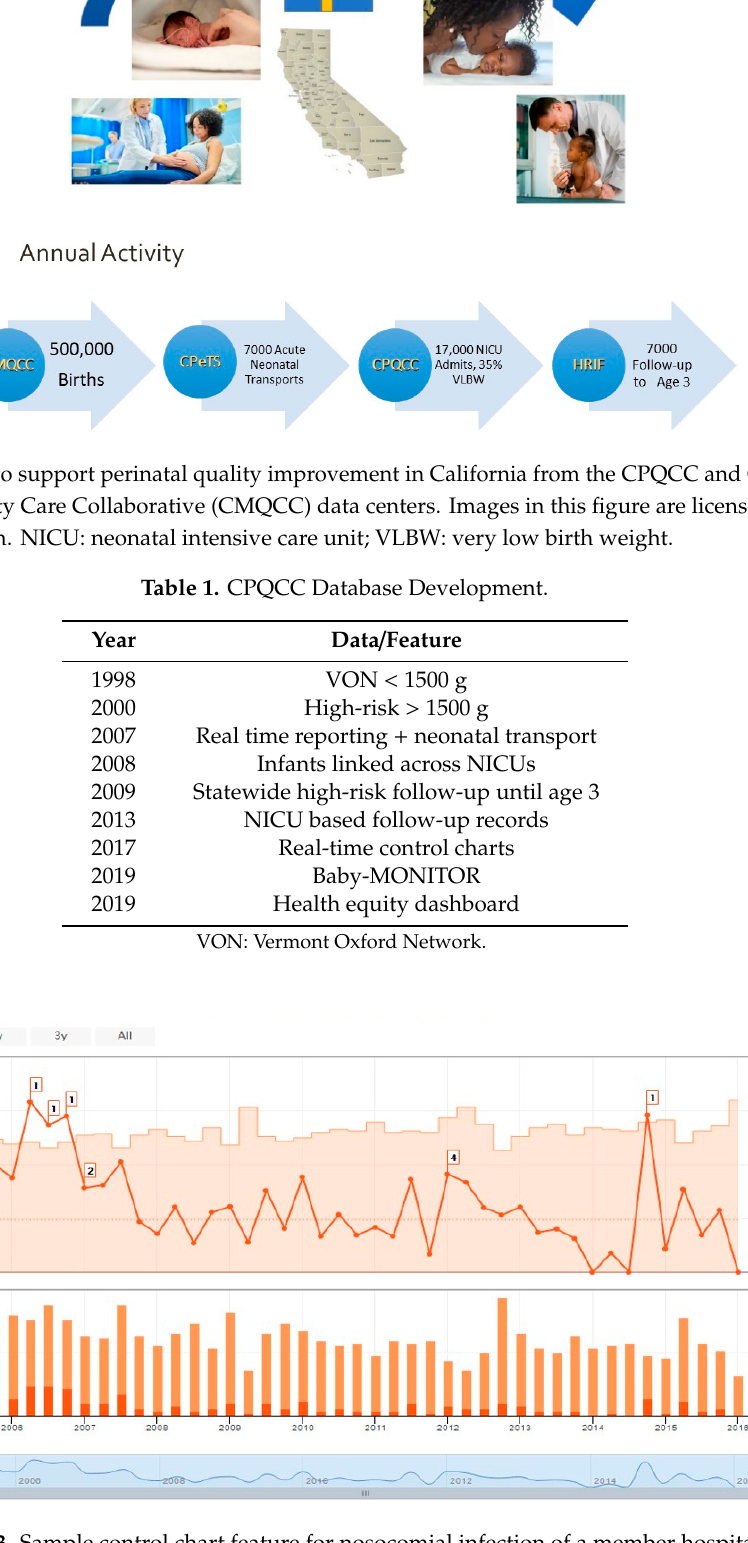
Figure 3. Sample control chart feature for nosocomial infection of a member hospital.